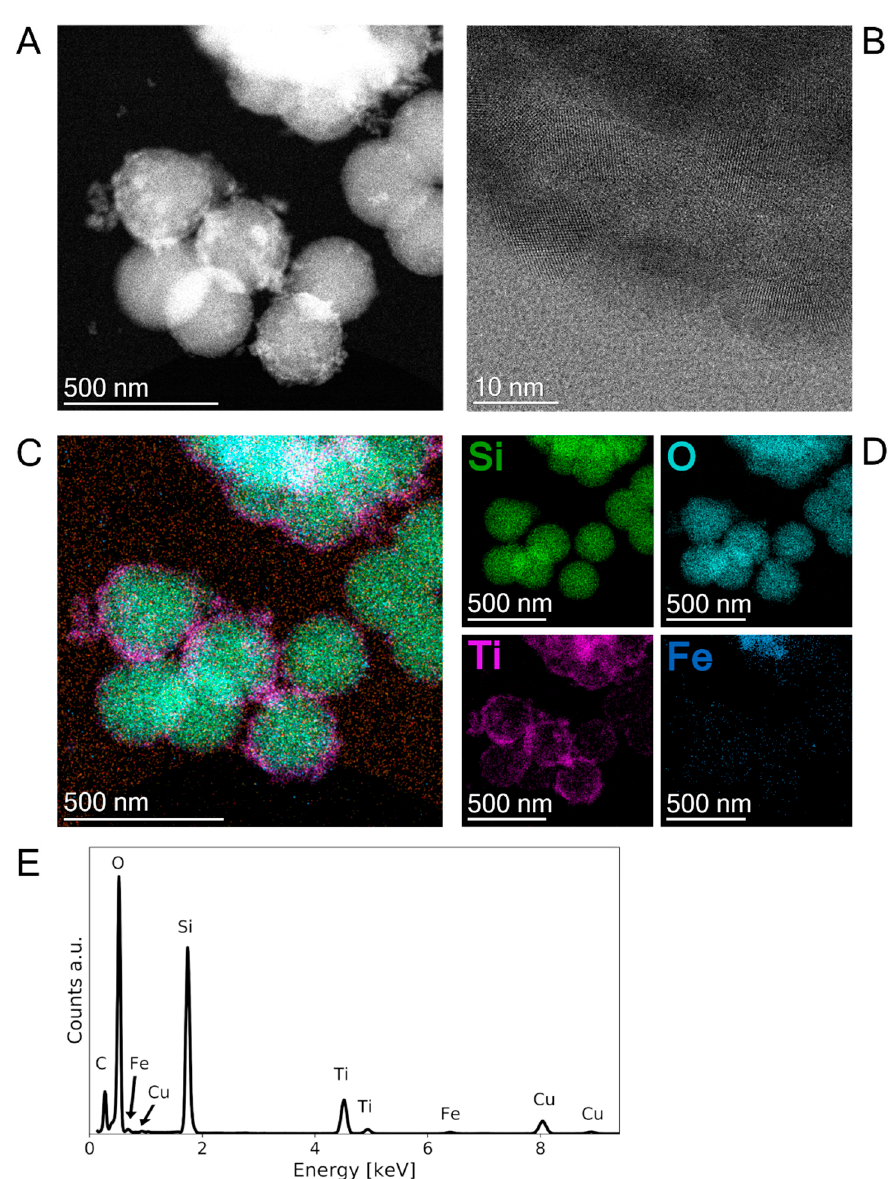
Figure 2. STEM of the Fe 3 O 4 –SiO 2 –TiO 2 catalyst. ( A ) HAADF-STEM overview image, ( B ) BF-STEM zoom-in of the surface of one Fe 3 O 4 –SiO 2 –TiO 2 particle. ( C ) EDX elemental map, ( D ) respective Ti, O, Si and Fe element distribution images and ( E ) corresponding spectrum of Fe 3 O 4 –SiO 2 –TiO 2 cata- lyst.